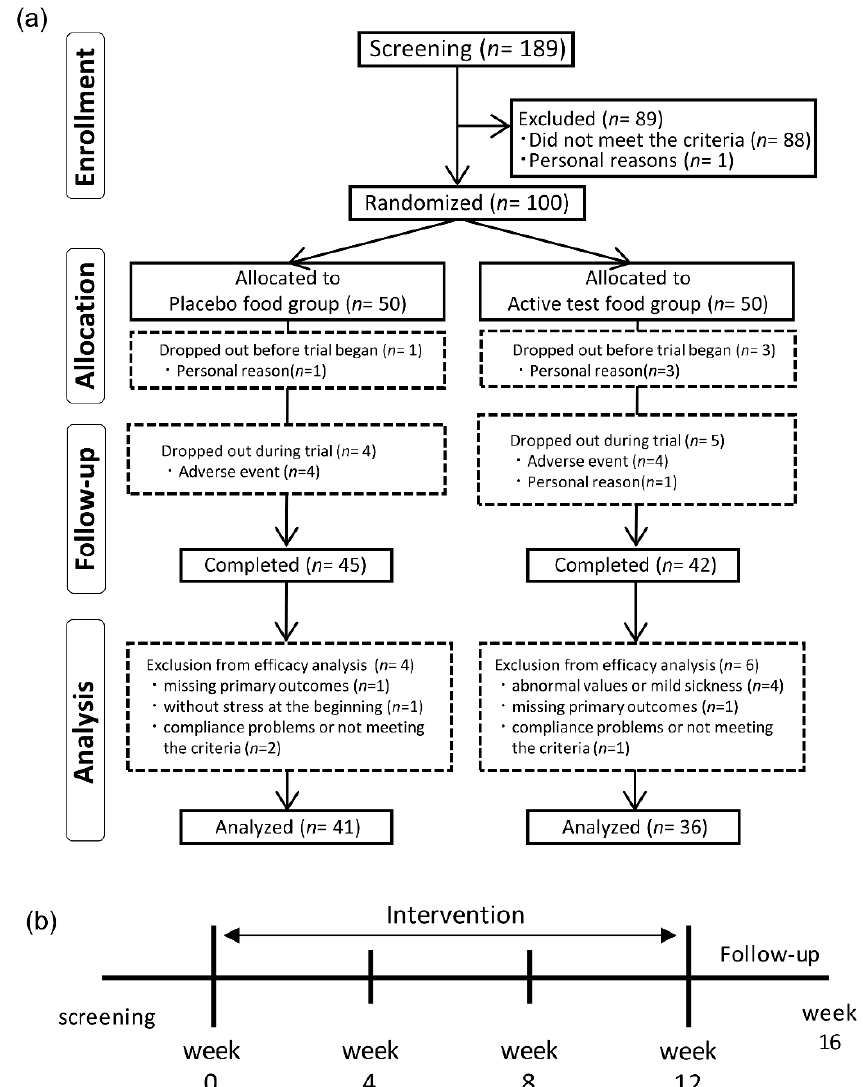
Figure 1. Flowcharts of ( a ) participant election and ( b ) study schedule.